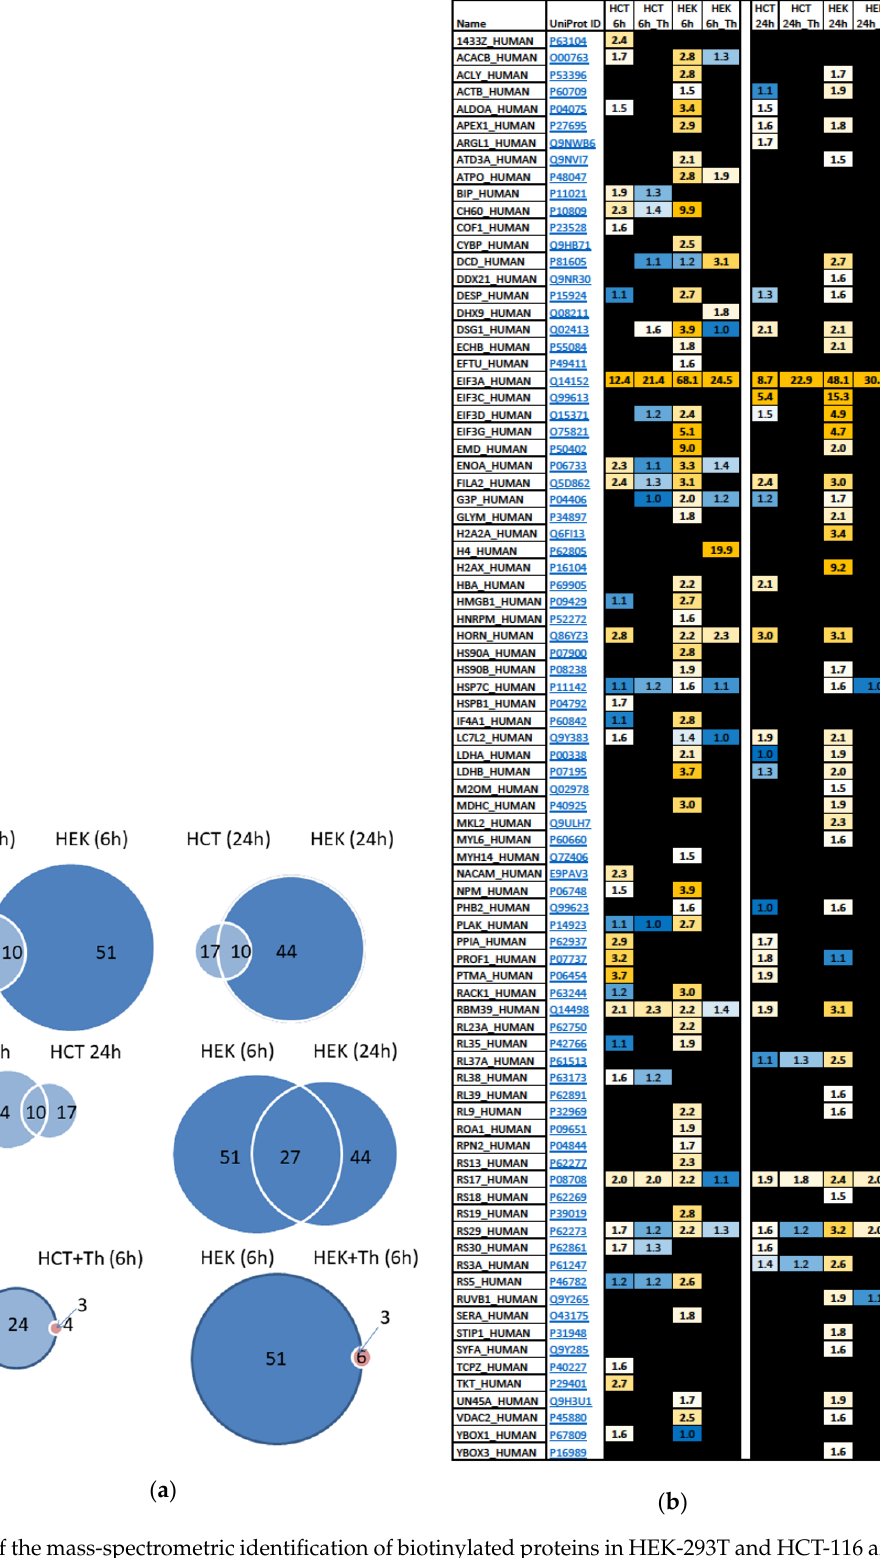
Figure 3. Results of the mass-spectrometric identification of biotinylated proteins in HEK-293T and HCT-116 after 6 and 24 h of labeling with biotin. MS data were analyzed as described in the method section. Only proteins that were significantly enriched at least 1.5-fold in the myc-BirA*-eIF3A transfections, in comparison to BirA* transfection for at least one experimental condition, are included. ( a ) Diagrams comparing identified proteins between the experimental conditions. ( b ) Heat map illustrating the eIF3A-dependent biotinylation ratio for all identified interacting proteins under all experimental